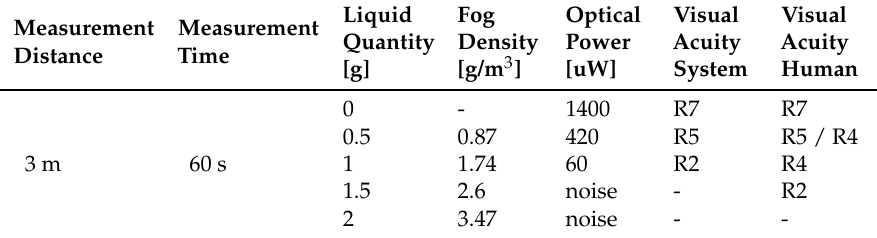
Table 1. Results for visual acuity measurement—system vs human